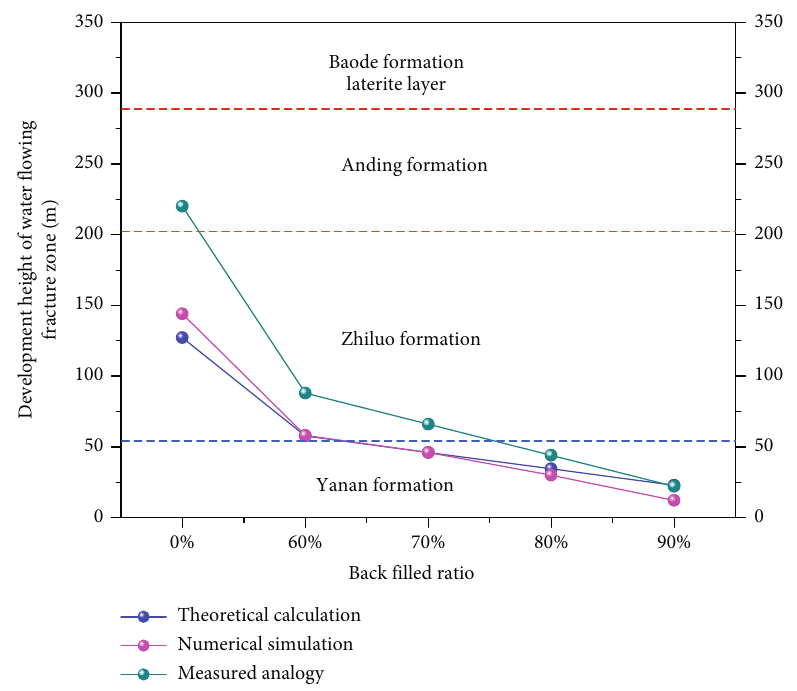
Figure 9: Detailed analysis of the height of water-conducting fractured zone under di ff erent mining conditions.